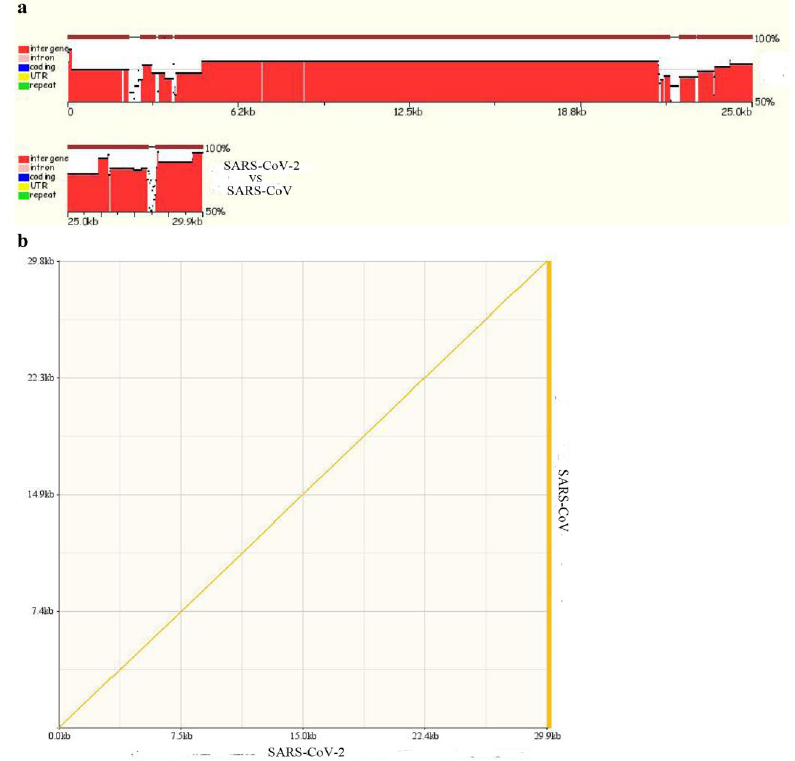
Figure 4. ( a ) Genomic sequence alignment between SARS-CoV-2 and SARS-CoV; ( b ) Dot plot matrix calculated for the complete genomes of SARS-CoV-2 and SARS-CoV.